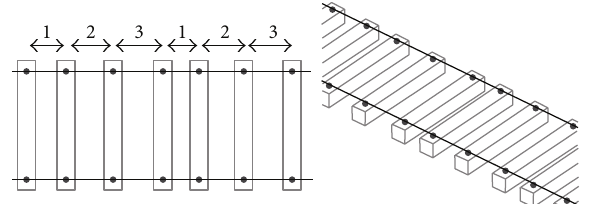
Figure 10: Scheme of rack with the change of sleeper spacing, distances 𝑑 𝑖 = 𝑑 1 + Δ 𝑖 .